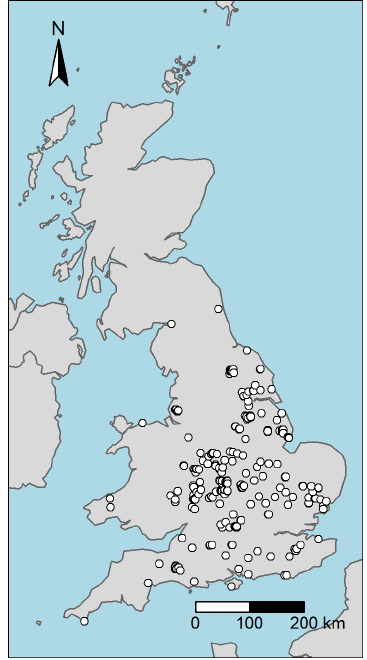
Figure 2. Location of the 265 soil profiles used in this study. Data source: Land Information System (LandIS) (LandIS,